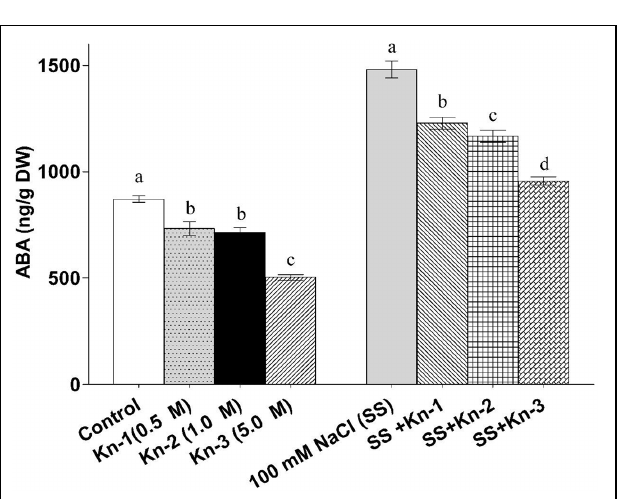
FIGURE 6 | Effect of exogenous application of Kn and NaCl on the endogenous level of free [Salicylic acid (salicylic acid)] SA of soybean shoots. Seedlings of soybean were exposed to different concentrations of Kn and NaCl after 17 days of sowing (17 DAS) and harvested after 24 h. Graph represents data from nine replicates in two independent experiments (data are mean ± SD; n = 18). Bars labeled with different letters shows significant difference ( p < 0.05; Duncan test).